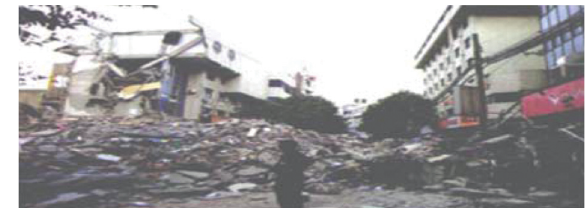
Figure 1: The collapse of buildings blocking